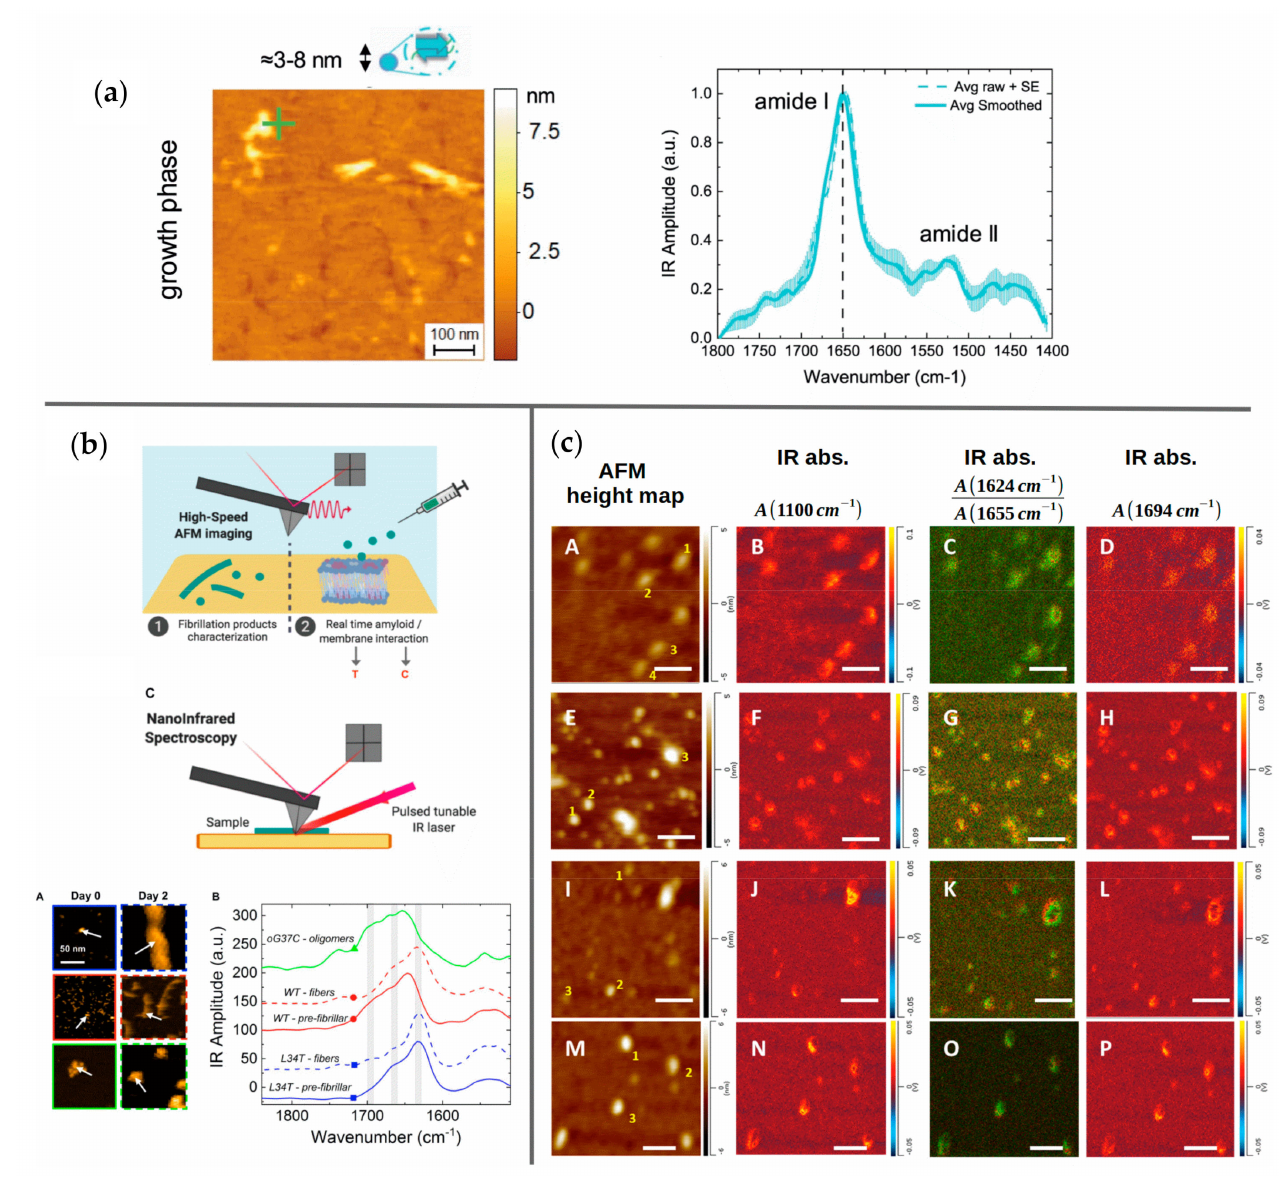
Figure 4. ( a ) AFM maps of A β 42 oligomers with corresponding IR spectra. Part of figure reproduced from Ref. [88] with permission. ( b ) Schematic illustration of an AFM-IR setup (above). AFM maps of amyloid fibrils and oligomers with corresponding IR spectra (below). Part of figure reproduced from Ref. [89] with permission. Copyright 2020 Feuillie et al. ( c ) AFM maps and corresponding IR line absorption maps of various oligomeric aggregates. Part of figure adapted with permission from Ref. [90]. Copyright 2021 American Chemical